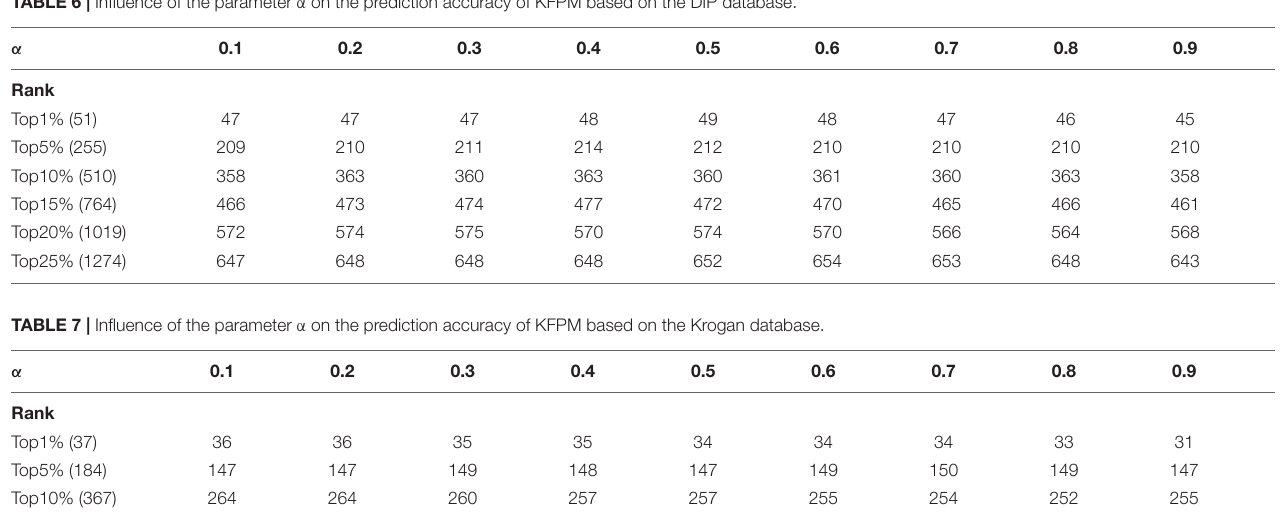
TABLE 6 | Influence of the parameter α on the prediction accuracy of KFPM based on the DIP database.